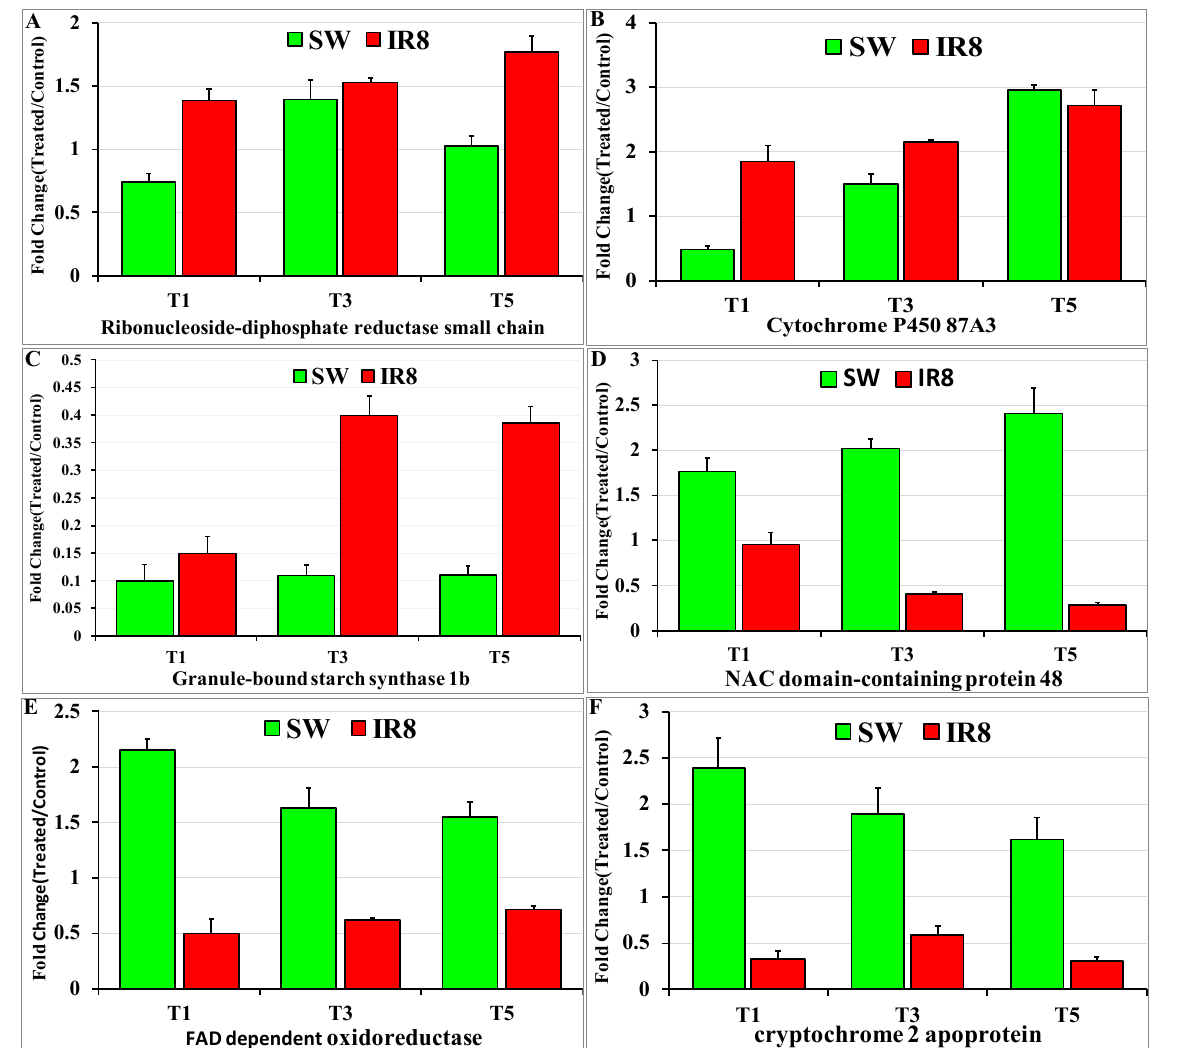
Figure 8. Expression analysis of target genes of identified five novel miRNAs in T1, T3, and T5 samples of Swarnaprabha (SW) and IR8 with respect to control. ( A ) Ribonucleoside-diphosphate reductase expression, a target of miRNA osa-novmiR1 ; ( B ) cytochrome P450 87A3, a target of miRNA osa-novmiR2 ; ( C ) GBSS1b, a target of miRNA osa-novmiR3; ( D ) NAC domain-containing protein, a target of miRNA osa-novmiR4; ( E ) FAD-dependent oxidoreductase, a target of miRNA osa-novmiR5; and ( F ) cryptochrome2 apoprotein, a target of miRNA osa-novmiR5. Each gene was amplified using gene-specific primers designed using Primer Blast. Actin was taken as an internal positive control. The primer sequences are provided in Table S3. Error bars are ± SD of the average of three qRT-PCR